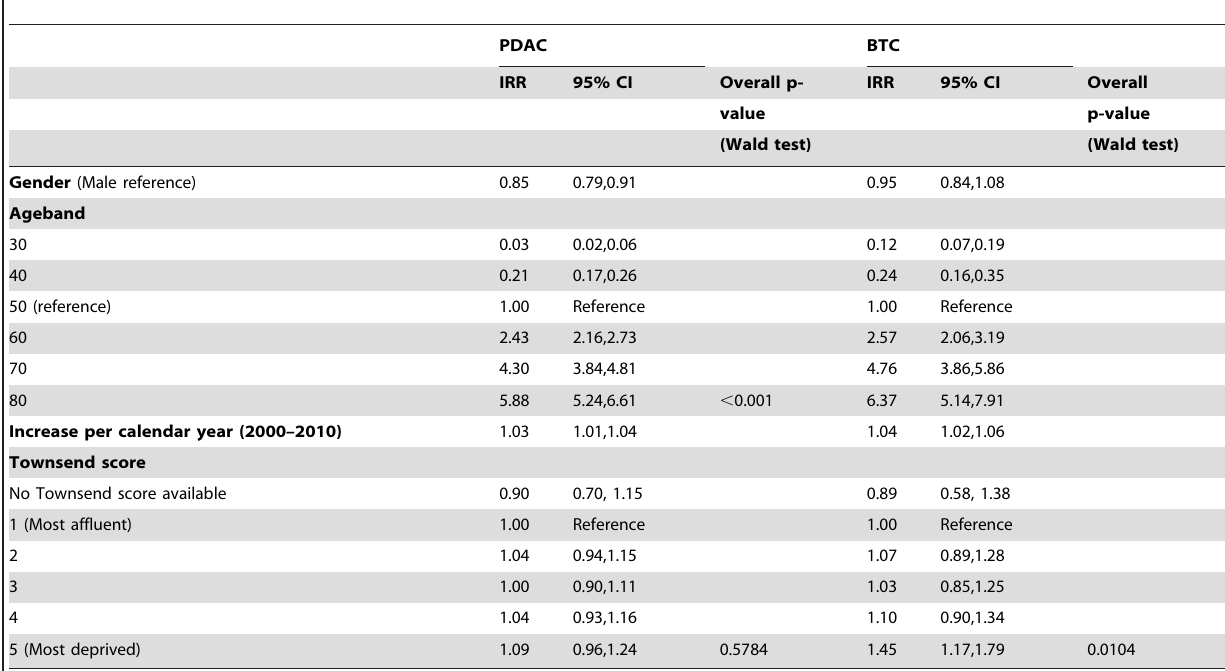
Table 2. Results of multivariable Poisson regression to identify socio-demographic variables in PDAC and BTC in the primary care